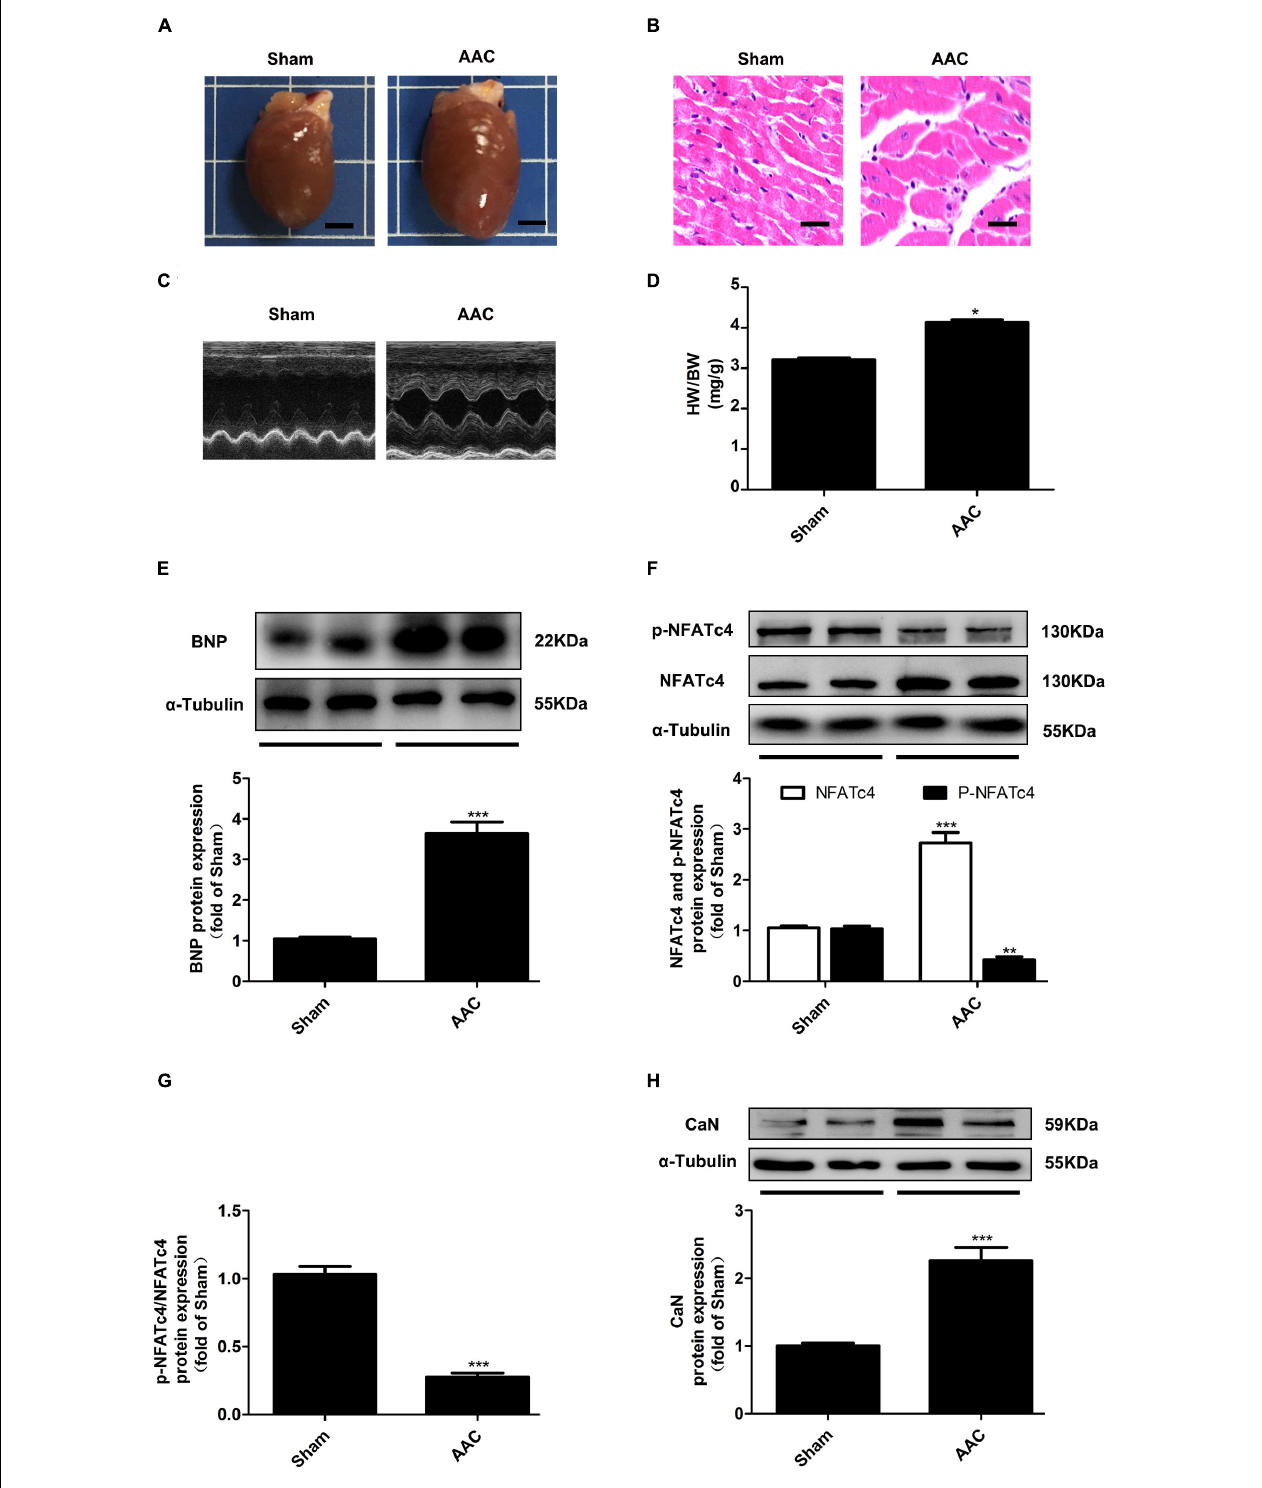
FIGURE 2 | Changes of NFATc4 expression in pressure overload-induced cardiac hypertrophy in vivo . (A) Gross hearts from both AAC and Sham rats. Scale bar: 0.4 cm. (B) Histological analysis detected by hematoxylin and eosin staining. Scale bar: 10 µ m. (C) Representative echocardiography analysis for both AAC and Sham rats. (D) The ratio of heart weight to body weight (HW/BW) were measured. Western blotting analysis was conducted to determine the protein expression of (E) BNP, (F) total NFATc4, phosphorylated NFATc4, (G) p-NFATc4/NFATc4 ratio, and (H) the protein expression of calcineurin in AAC and Sham rats. The data were presented as mean ± SEM. ∗ P < 0.05, ∗∗ P < 0.01, ∗∗∗ P < 0.001 vs. Sham, n = 6.